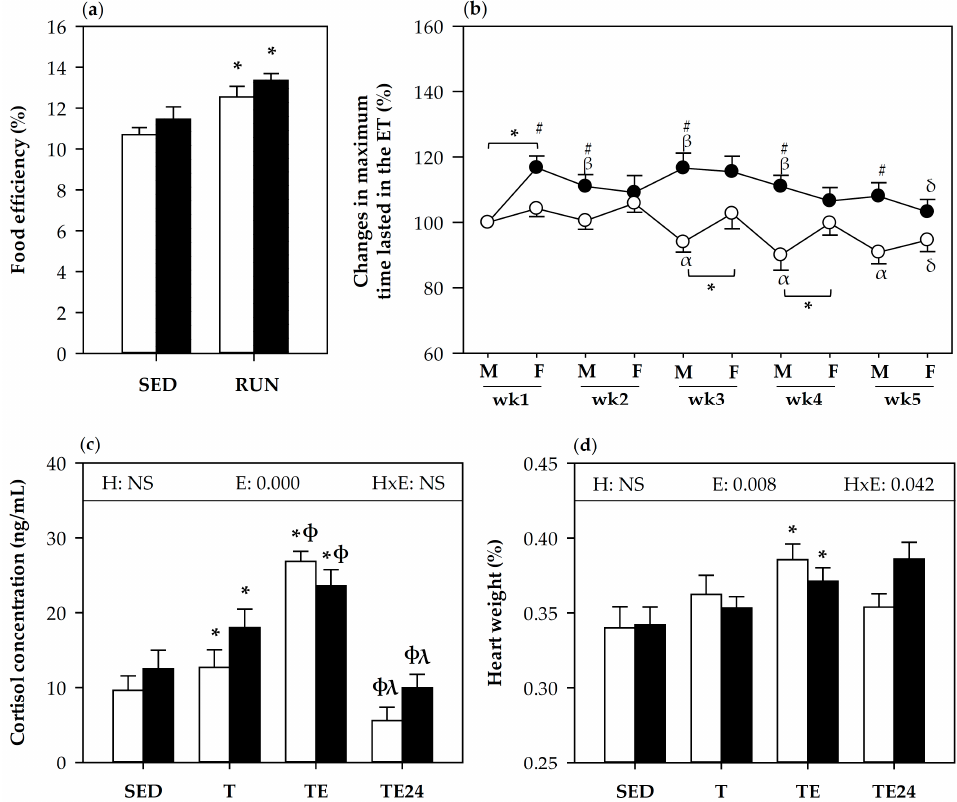
Figure 1. Food efficiency during the study ( a ), changes in maximum time supported in the exhaustion tests performed throughout the study (percentage with respect to the first exhaustion test) ( b ), cortisol concentration ( c ), and relative heart weight ( d ) at the end of the study. ET = exhaustion test; F = Friday; M = Monday; RUN = runner animals; SED = sedentary animals; T = trained groups; TE = T groups with an additional exhaustion test; TE24 = TE groups 24 h after the exhaustion test; wk = week. NS = no statistically significant differences detected. The non-supplemented group is represented by white symbols ( ⚪ ) and bars, and the hesperidin-supplemented group by black symbols ( ⚫ ) and bars. Data are expressed as mean ± standard error of the mean (SEM, n = 3-8 for a , n = 24 for b , n = 8 for c and d ). Statistical difference in ( a , c , d ), the inset table shows two-way analysis of variance (ANOVA) results when applied (H, hesperidin; E, exercise, H–E, interaction between hesperidin and exercise): * p < 0.05 vs. SED group; φ p < 0.05 vs. T group; λ p < 0.05 vs. TE group. Statistical difference in ( b ): * significant differences between consecutive ETs for both non-supplemented and the hesperidin-supplemented groups ( p < 0.05); α significant differences in the non-supplemented group vs. the first and the second Monday ET ( p < 0.05); β significant differences in the hesperidin-supplemented group vs. the first Monday ET ( p < 0.05) and δ significant differences in both non-supplemented and hesperidin-supplemented groups vs. the first Friday ET (repeated-measures ANOVA followed by paired Student’s t test); # significant differences between non-supplemented and the counterpart hesperidin-supplemented group ( p < 0.005, Student’s t- test).